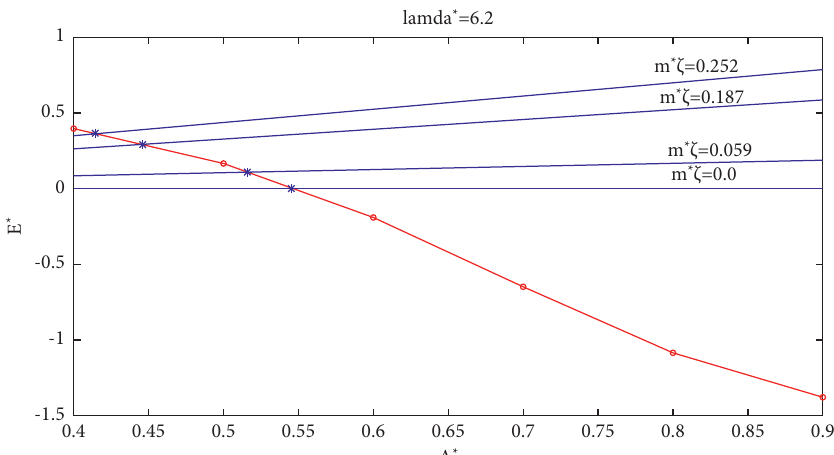
Figure 13: Prediction of amplitude response A ∗ at different mass damping when λ ∗ � 6 . 2.